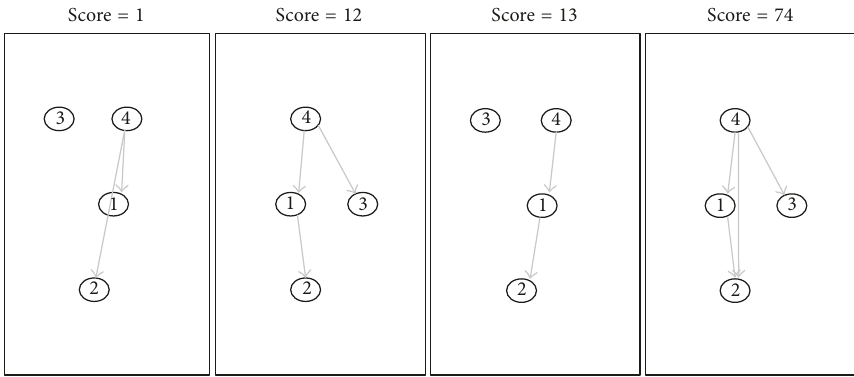
Figure 3: Network structure under Bayesian scoring criterion.